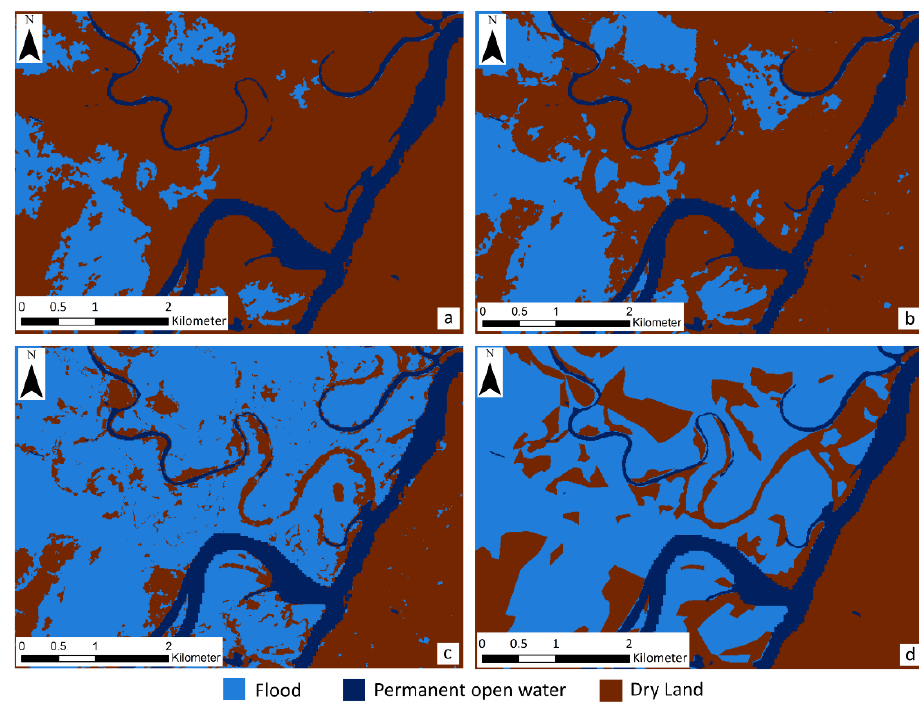
Figure 13. Classification result of the S-1FS ( a ), classification results of the S-1FS supplemented by TOW areas of the time series approach ( b ), classification results of the S-1FS supplemented by TOW and TFV areas of the time series approach ( c ), and validation image with merged flood areas (TOW + TFV) ( d ).